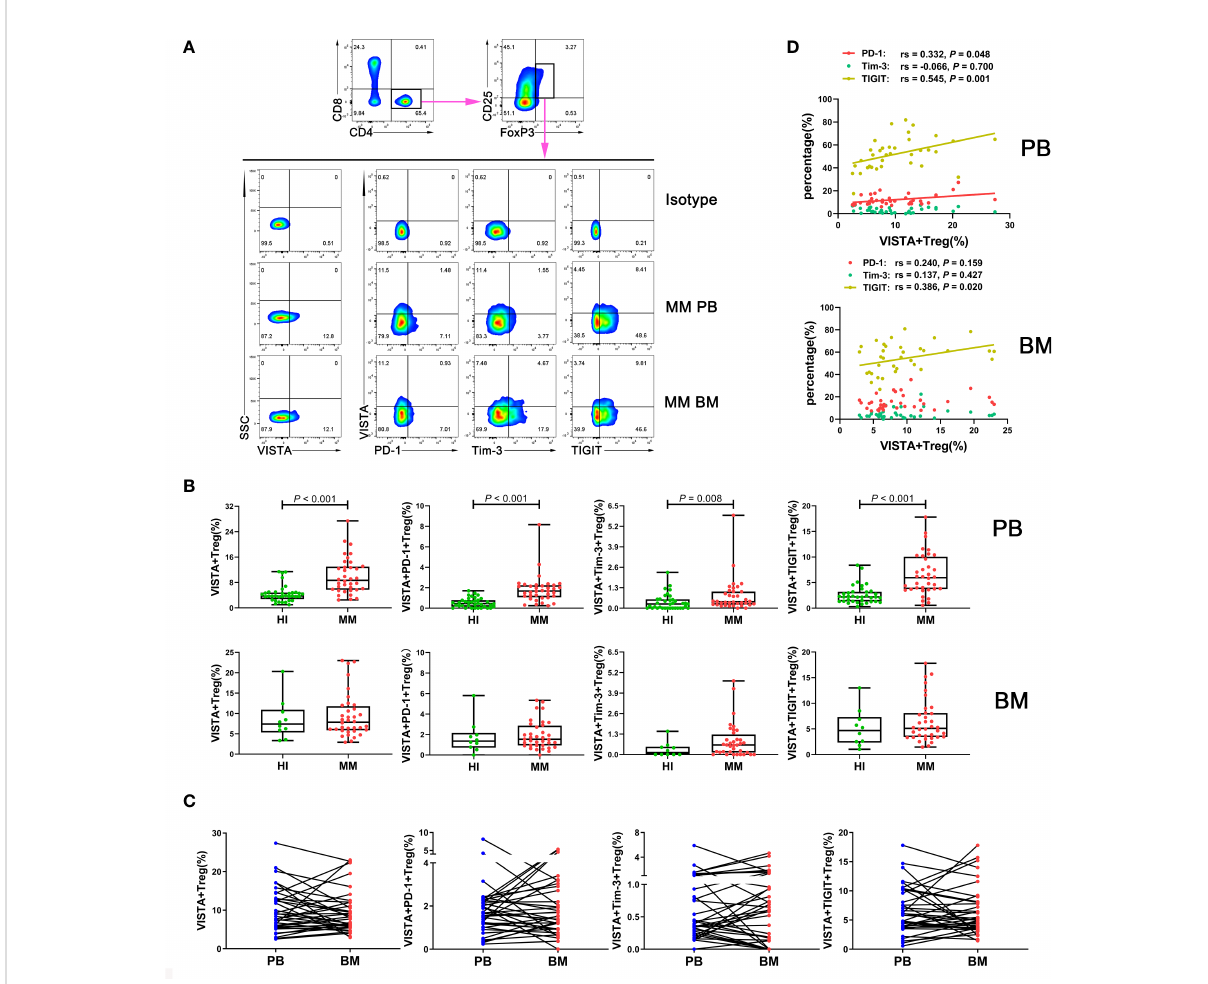
FIGURE 2 Distribution and frequency of VISTA expression and co-expression with PD-1, Tim-3, and TIGIT on Treg cells in PB and BM from MM patients. (A) Detection of VISTA, PD-1, Tim-3, and TIGIT expression in Treg cells in a patient with MM by fl ow cytometry. (B) Comparison of the percentage of VISTA+, VISTA+PD-1+, VISTA+Tim-3+, and VISTA+TIGIT+ Treg cells in MM and HIs. (C) Comparison of the percentage of the VISTA+, VISTA+PD-1+, VISTA+Tim-3+, and VISTA+TIGIT+ Treg cell subsets between PB and BM from 36 patients with MM. (D) Correlation between the percentages of VISTA+ and PD-1+, Tim-3+, and TIGIT+ T cells in Treg cells from MM